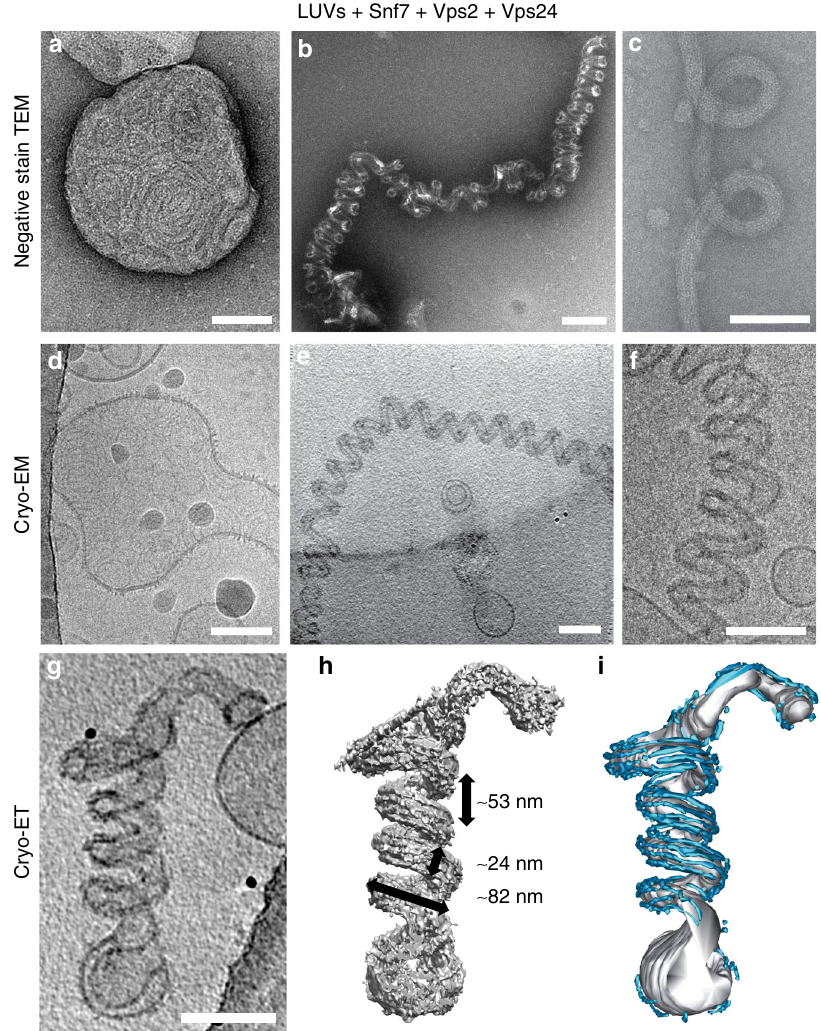
Fig. 1 Helical tubulation of liposomes by ESCRT-III heteropolymers. Electron micrographs showing undeformed liposomes ( a , d ) and helical membrane tubes ( b , c , e , f ) decorated with Snf7/Vps24/Vps2 on negatively stained ( a – c ) and vitri fi ed ( d – f ) samples. The reconstructed cryo-ET volume of a helical membrane tube projected in Z ( g ) and volume view after fi ltering ( h ) or manual segmentation ( i ) showing the organization of protein fi laments (cyan) along the helical membrane tube axis (gray). The helical tube dimensions are rounded averages, for details see Supplementary Table 1. All scale bars 100 nm. Source data are provided as a Source Data fi